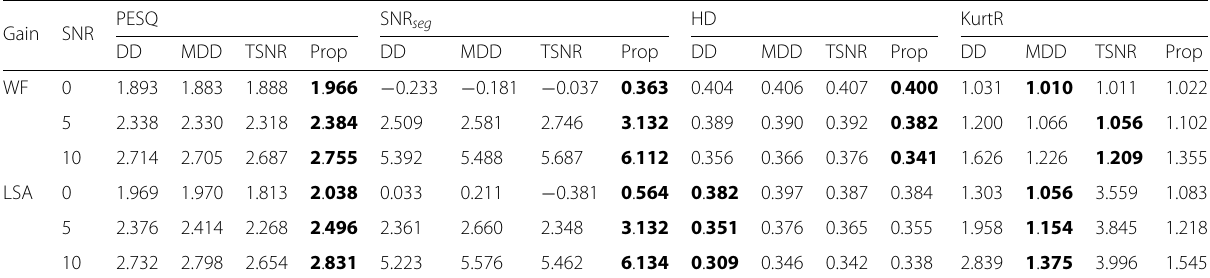
Table 5 Mean objective results for F16 Cockpit noise